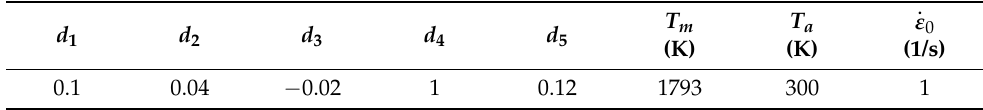
Table 3. Input data for the Johnson–Cook damage initiation model.